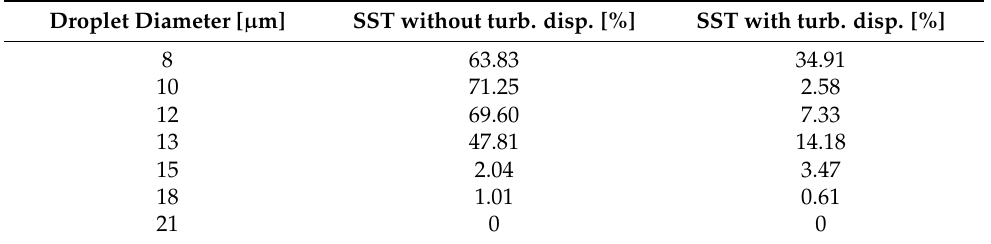
Table 7. Relative errors between calculated results obtained with SST model with and without using turbulent dispersion with experimental data for geometry B_10_0 with inlet velocity 2 m s − 1 .